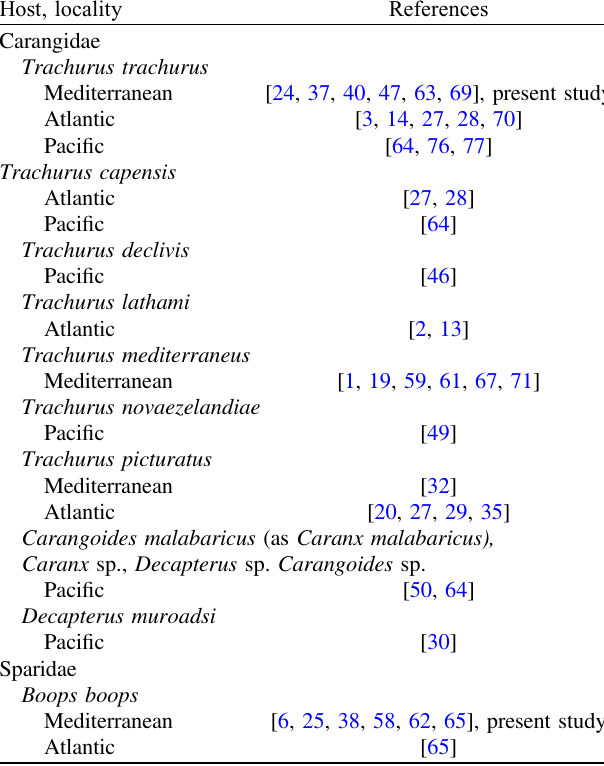
[ . . . ] coronata da un cerchio di 24 uncini minutissimi (Fig. 11), con base allargata e punta arcuata rivolta verso il lume del canale. Inferiormente e nell ’ interno della cloaca si osserva altro cerchio di aculei (Fig. 12) molto più lunghi dei superiori (0,017) che soprastanno all ’ apertura del deferente e